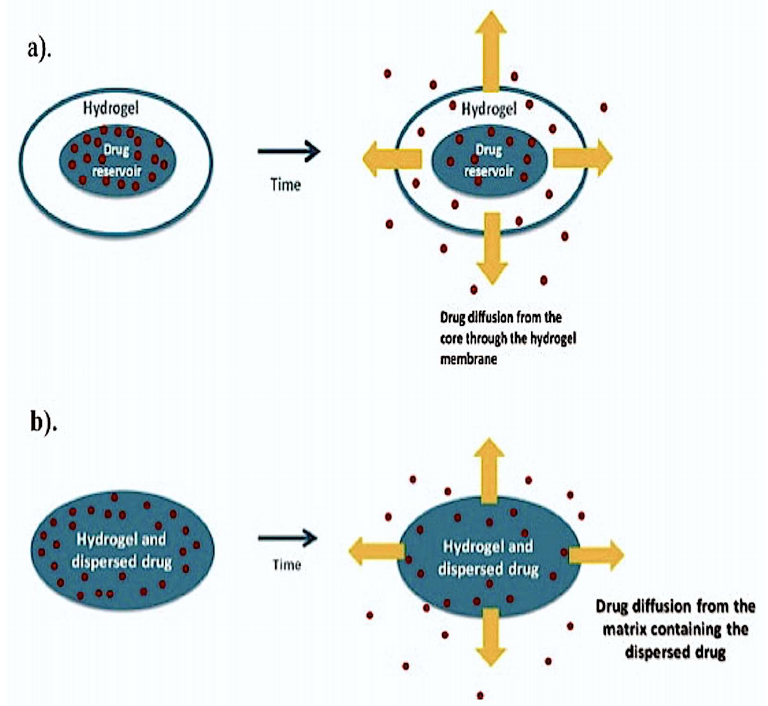
Figure 1. ( a ). Drug-containing core is coated with hydrogel membrane and the drug concentration is higher in the center of the system to allow constant release rate of the same in reservoir delivery system. ( b ). Uniform dissolution or dispersion of the drug throughout the 3D structure of the hydrogel is achieved using matrix delivery (reprinted (adapted) with permission from [3]; the article is open access and the content